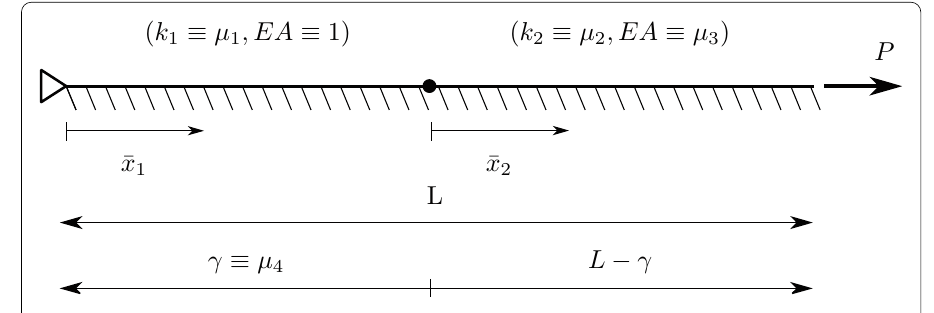
Fig. 4 A problem with two sections, connected at an intermediate point, defined by γ